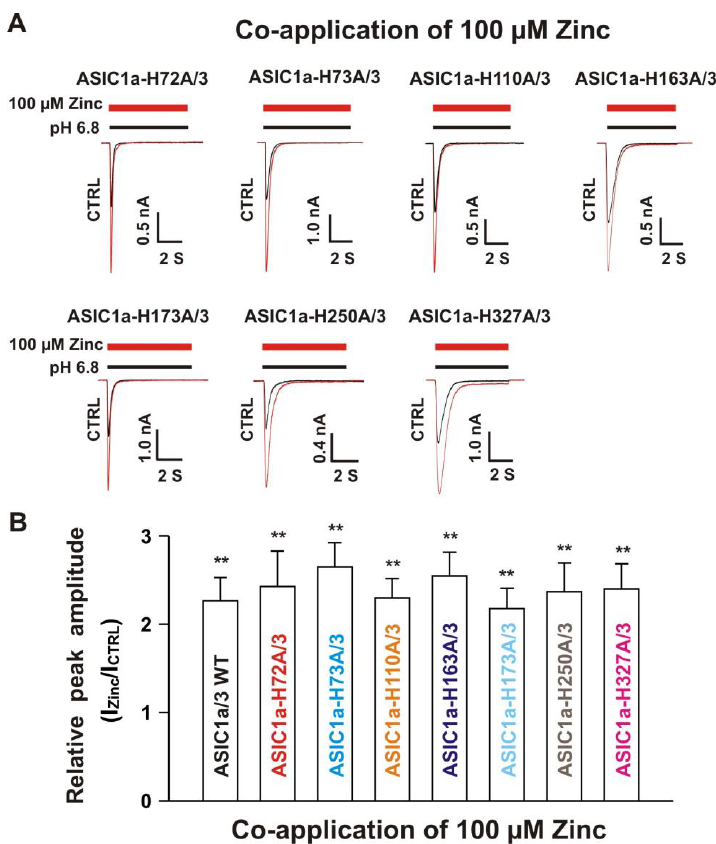
Figure 9. Co-application of zinc potentiated the currents of ASIC1a histidine mutant co-expressed with ASIC3 WT. ( A ) Representative traces show that co-application of zinc at a concentration of 100 µ M potentiated the peak amplitude of the currents recorded from heteromeric ASIC1a-H72A/3, ASIC1a-H73A / 3, ASIC1a-H110A / 3, ASIC1a-H163A / 3, ASIC1a-H173A / 3, ASIC1a-H250A / 3, and ASIC1a-H327A / 3; ( B ) Statistical bar graphs show relative peak amplitude of the currents from ASIC1a / 3 WTs and its histidine mutant / 3 as mentioned above by co-application of 100 µ M zinc ( n = 8 to 15). There was no significant difference for zinc potentiation among ASIC1a / 3 WTs with their histidine mutants co-expressed with ASIC3 WT ( p > 0.05, ANOVA). For ASIC1a mutation, histidine residues in the extracellular domain of ASIC1a were replaced with alanine. Whole-cell patch-clap recording was performed and currents from heteromeric ASIC1a / 3 WTs and ASIC1a histidine mutant / 3 were triggered by a drop in pH from 7.4 to 6.8. Data are presented as mean ± SEM. CTRL, control; I CTR , ASIC current without any treatment; I Zinc , ASIC current by zinc treatment. ** p < 0.01